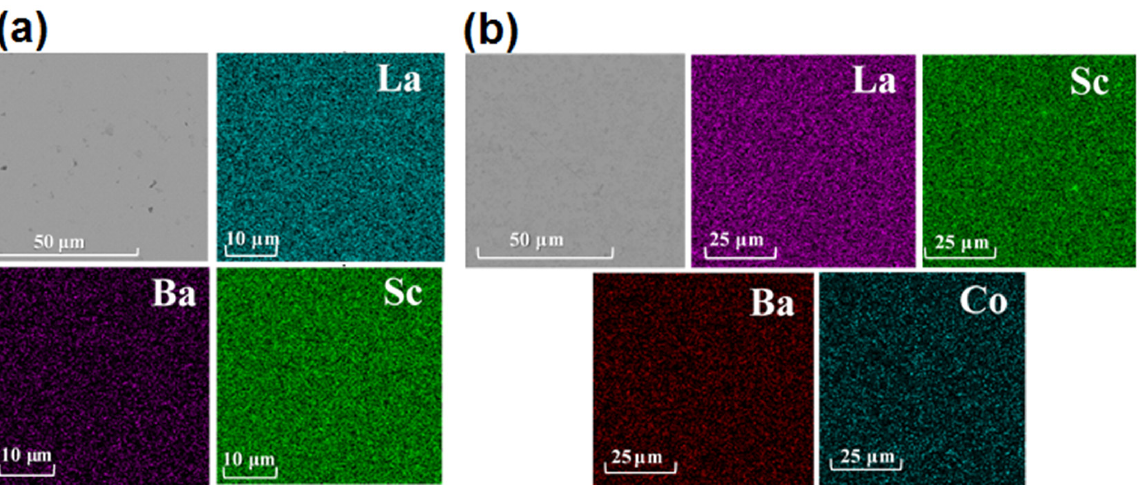
Figure 7. SEM images (BSE mode) of cross-sections for La 0.95 Ba 0.05 ScO 3- δ after vacuum sintering ( a ) and La 0.95 Ba 0.05 ScO 3- δ + 0.5 wt% Co 3 O 4 ( b ) with EDX maps of cation distribution. Table 2. Element contents (at.% ± 0.05) in the ceramics cross-sections according to EDX analysis. Sample